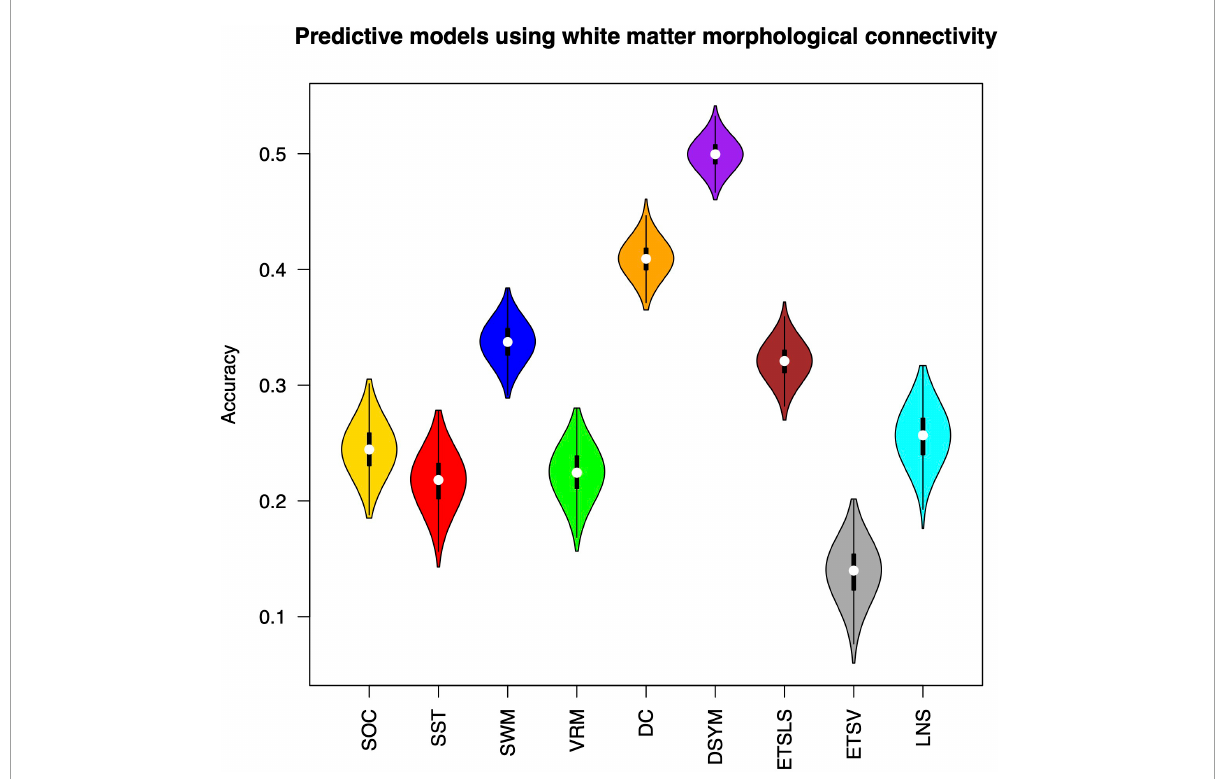
FIGURE2 Performance of the predictive models based on white matter morphological connectivity. The nine cognitive predictive models include the Stockings of Cambridge (SOC), the stop signal task (SST), the spatial working memory (SWM), the verbal recognition memory (VRM), the digit comparison (DC), the digit symbol (DSYM), the ETS advanced vocabulary (ETSV), the ETS letter sets (ETSLS), and letter number sequencing (LNS).